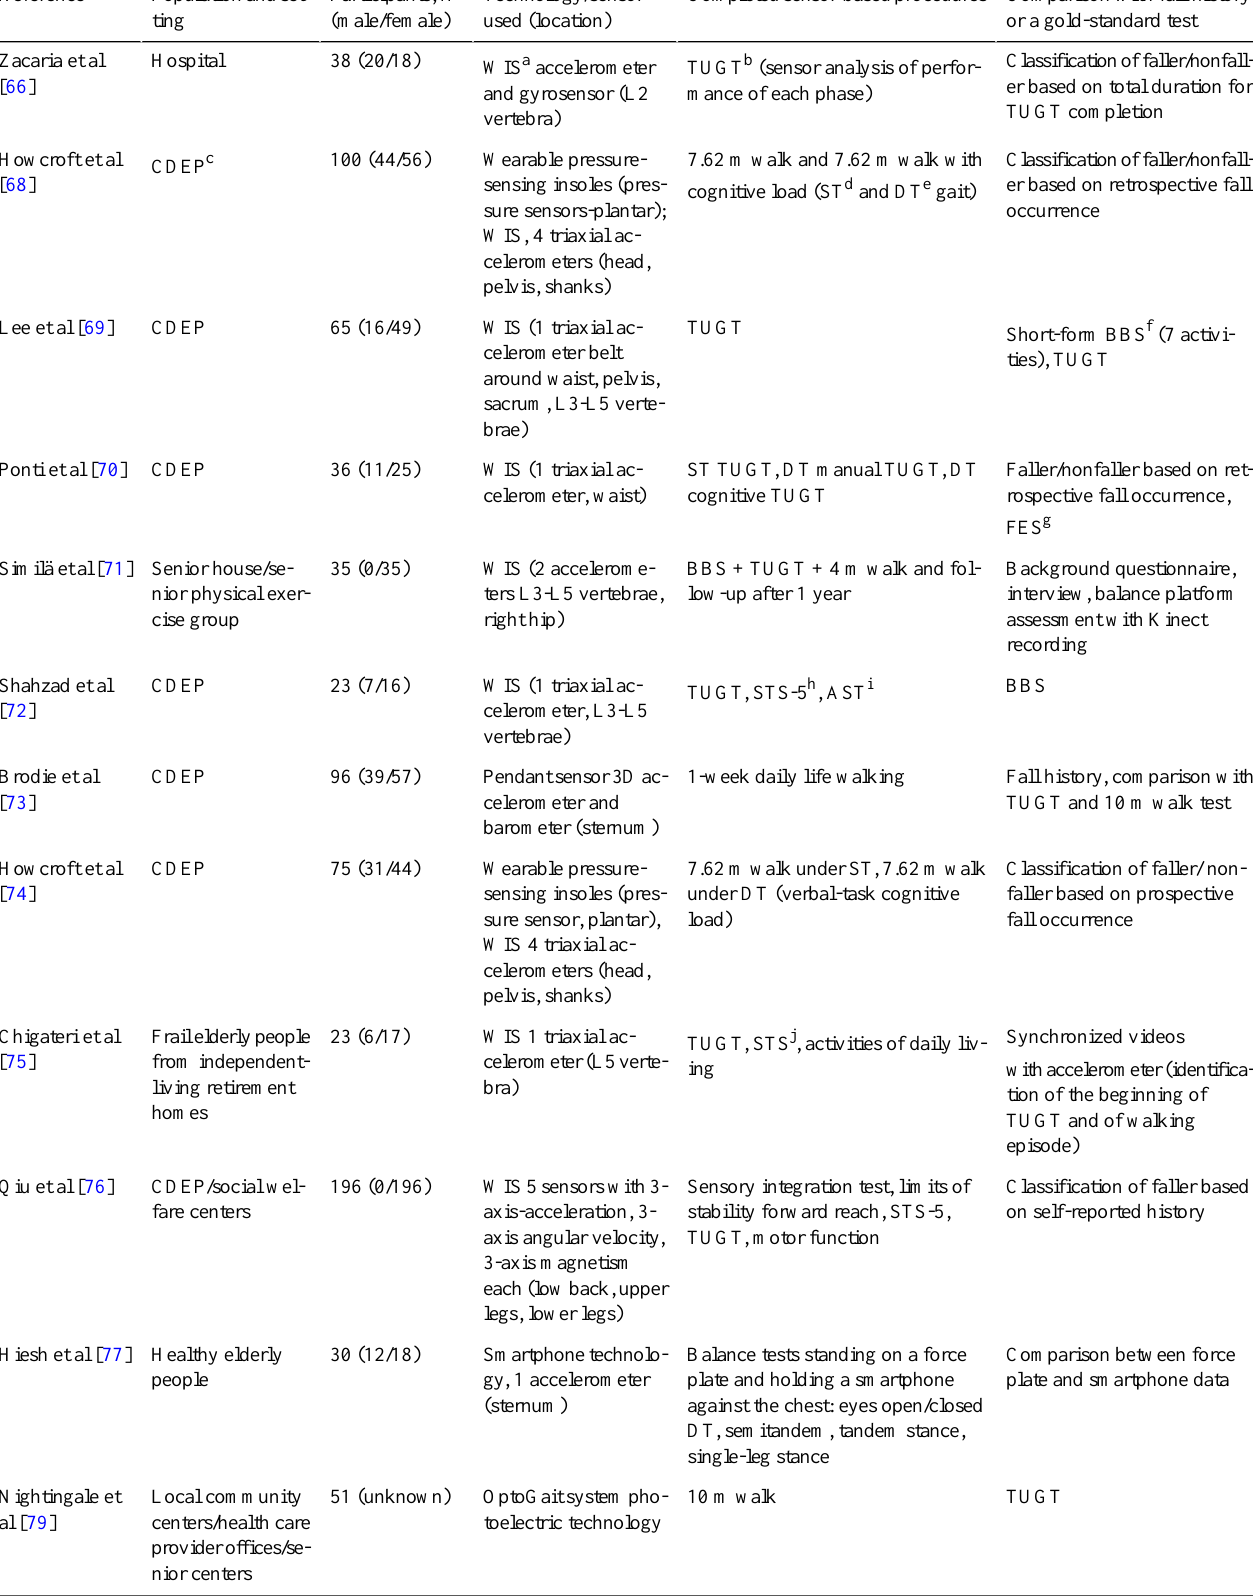
Comparison with fall